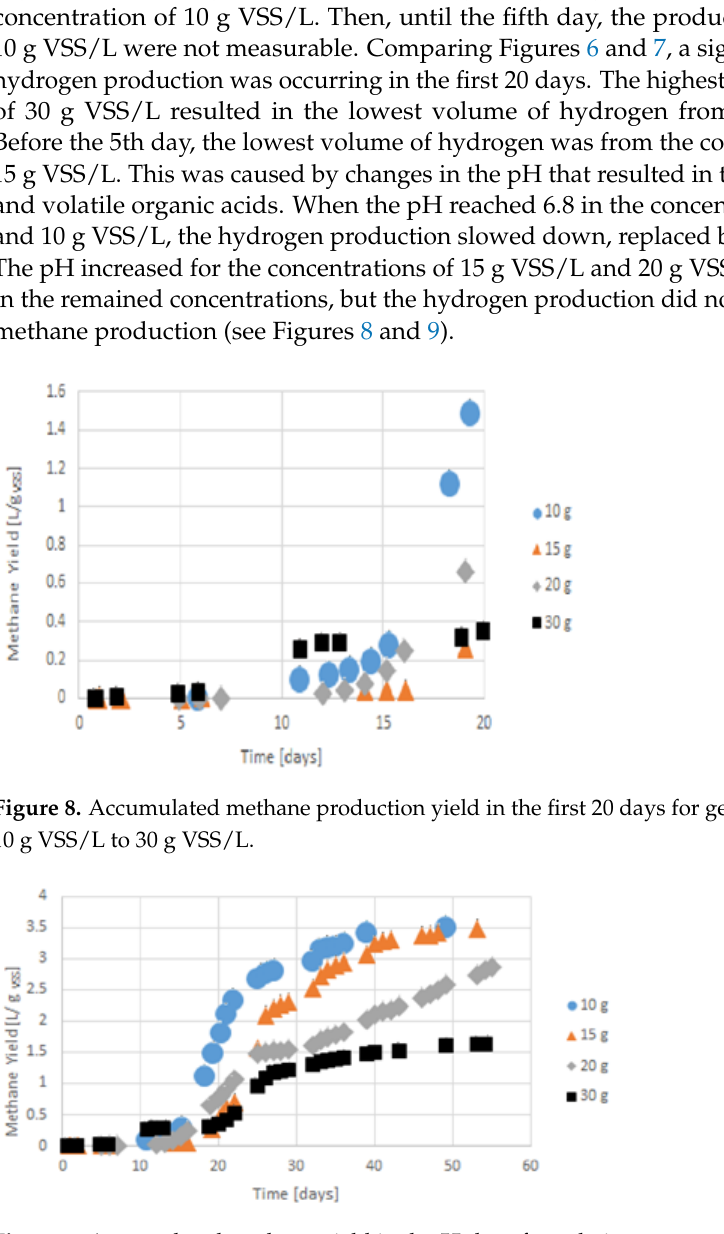
Figure 9. Accumulated methane yield in the 55 days for gelatine concentration from 10 g VSS/L to 30 g VSS/L.